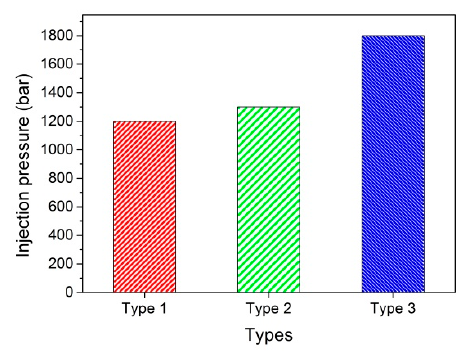
Figure 14. Comparison of the maximum injection pressure for representative Type 1, 2 and 3 DPI.